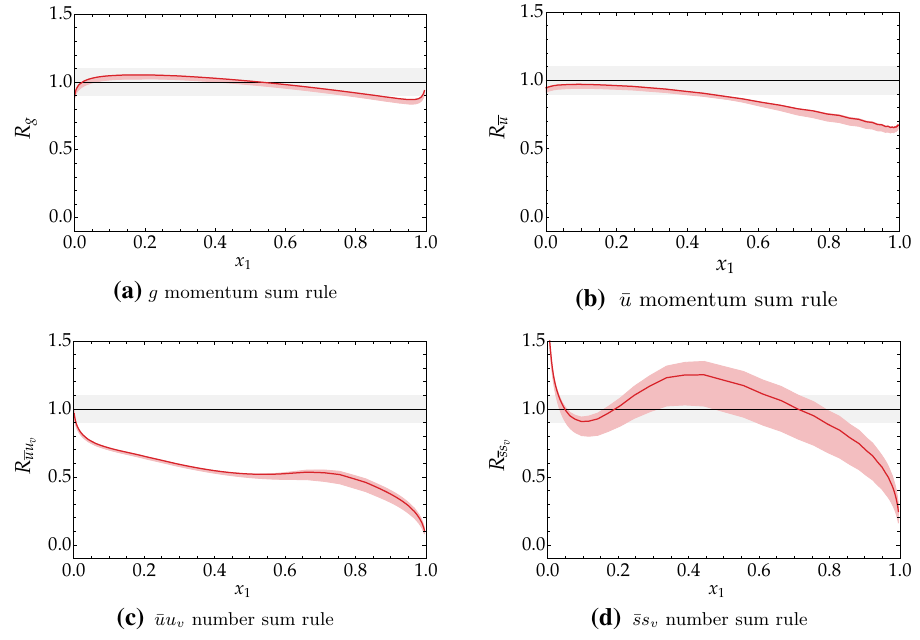
( d ) ¯ ss number sum v